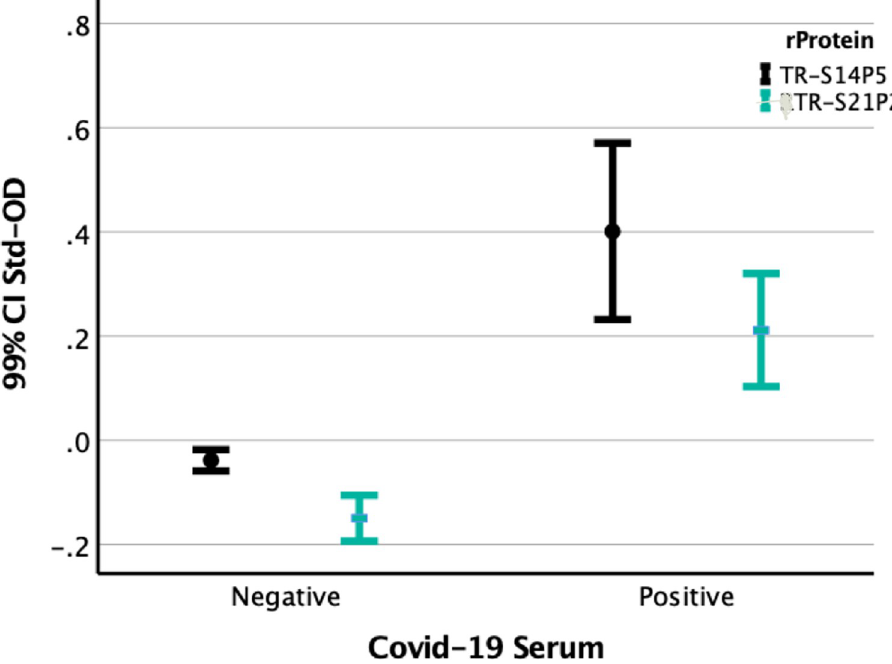
Fig 2. Differences in the level of antibodies to S14P5 or to S21P2 in sera from SARS CoV-2 infected and those from non-infected persons.